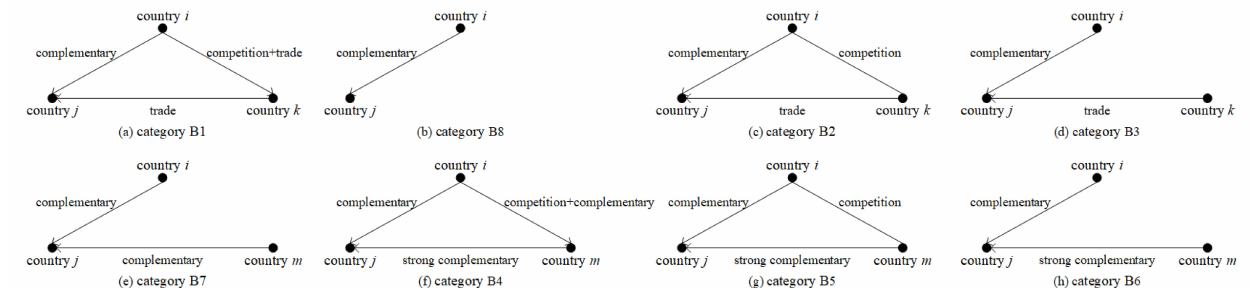
Figure 6. Classification of local network relations for category B potential trading